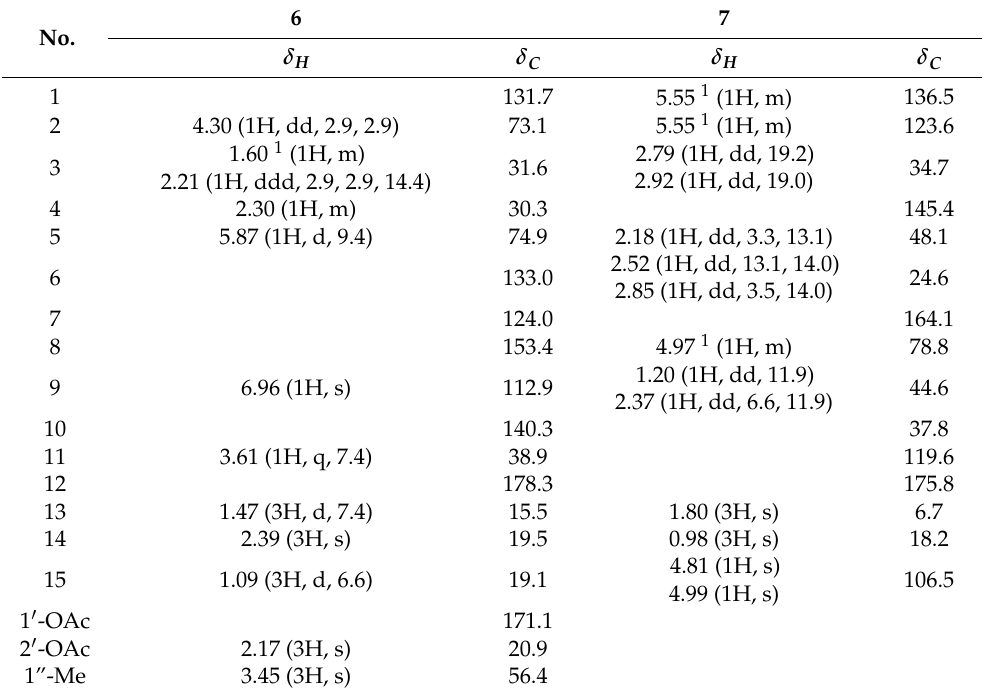
Table 3. 1 H and 13 C-NMR data for 6 (600 and 150 MHz, respectively; CDCl 3 ) and 7 (400 and 100 MHz, respectively; MeOD; δ in ppm, J in Hz, s singlet, d doublet, q quartet, br broad, m multiplet).